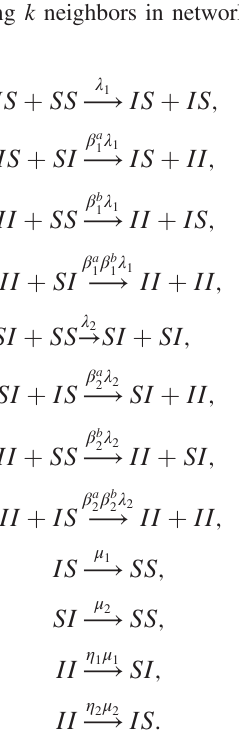
FIG. 1. SIS-SIS interacting diseases model. (left panel) Each of the diseases spreads over a different network. Each individual belongs simultaneously to each network and can be (or not) infected with each of the diseases (as indicated in the central panel). (right panel) Set of transitions allowed in the model. The variables ½ SS ð k; l Þ ; IS ð k; l Þ ; SI ð k; l Þ ; II ð k; l Þ(cid:2) represent the densities of individuals of each type in the system having k neighbors in network 1 and l neighbors in network